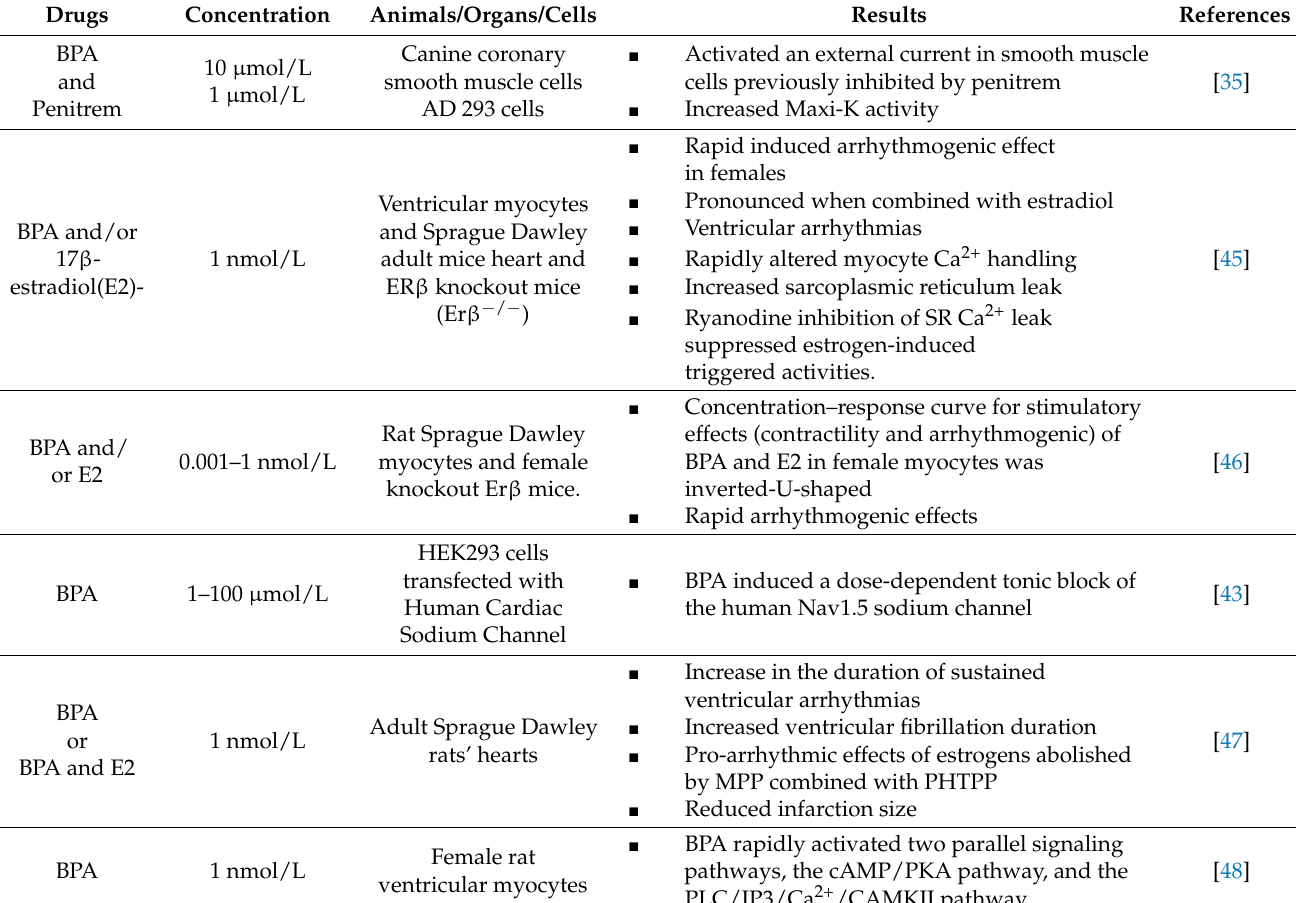
Table 1. Summaries of the disruptive effects of BPA in the animal in vitro studies 1